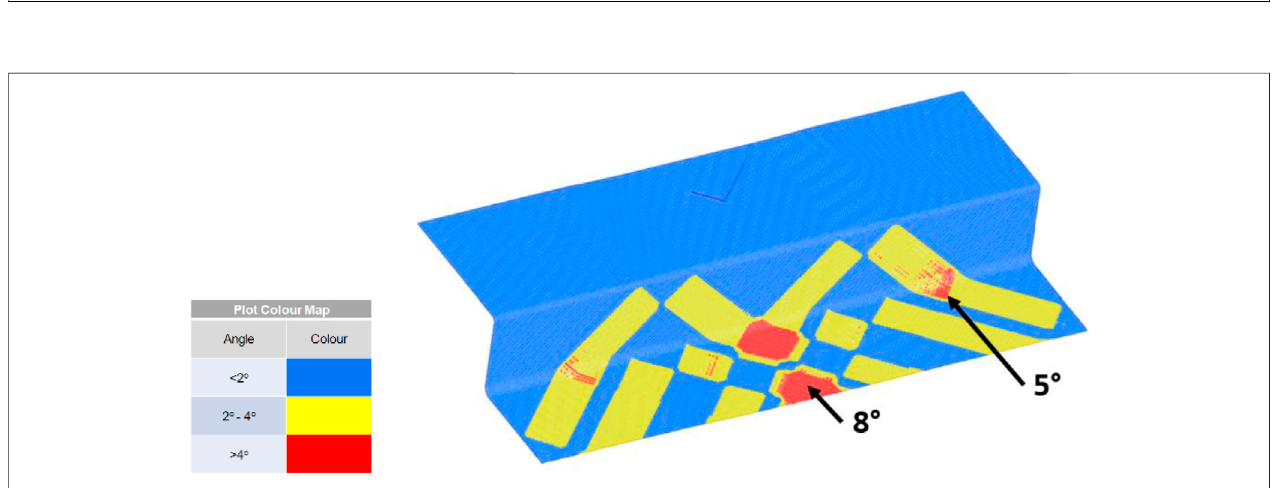
FIGURE 13 | Kinematic drape model shear map on ramp geometry.